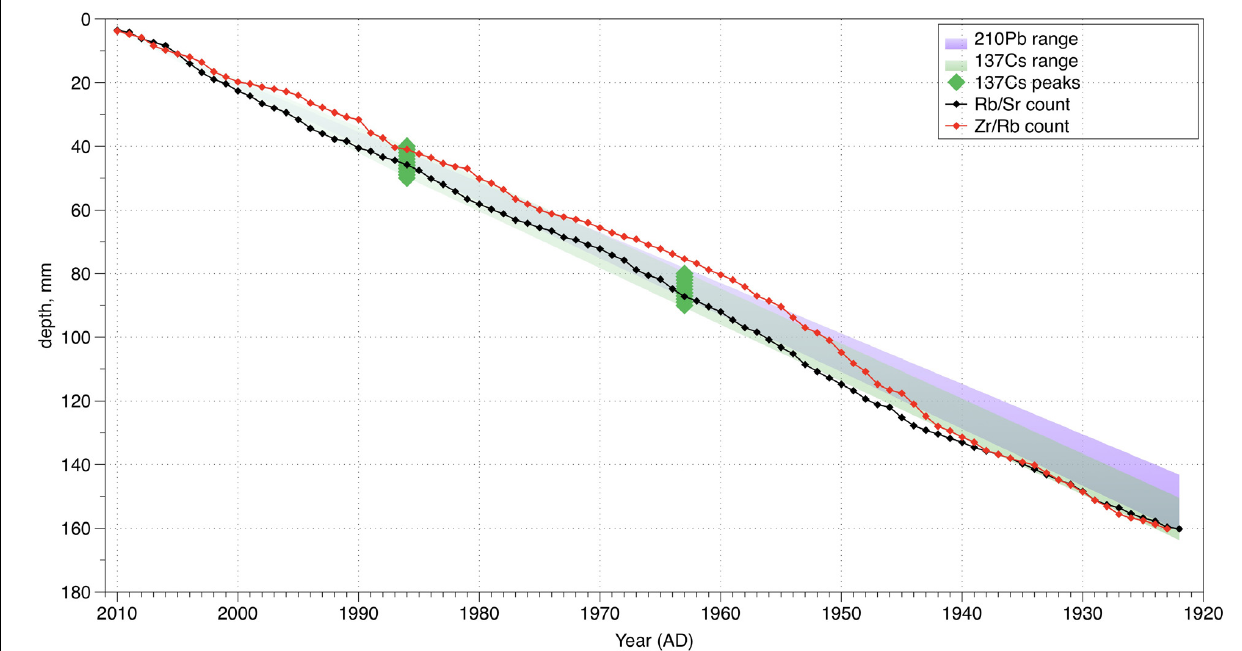
FIGURE 7 | Comparison of chronologies derived from XRF peak counting (Rb/Sr maxima and Zr/Rb minima) and isotopes ( 137 Cs and 210 Pb). Black and red dots mark annual layers according to Rb/Sr and Zr/Rb counts, respectively. Green dots mark the position of the two known peaks on the 137 Cs curve. Green and purple shaded areas show possible distribution of mean age-depth relations for 137 Cs and 210 Pb, respectively.